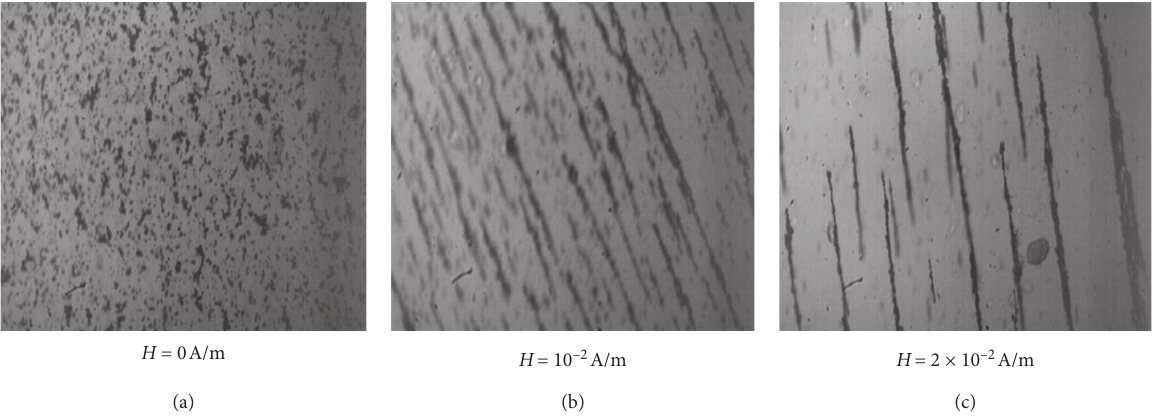
Figure 5: Microstructure of magnetorheological fluid under different magnetic